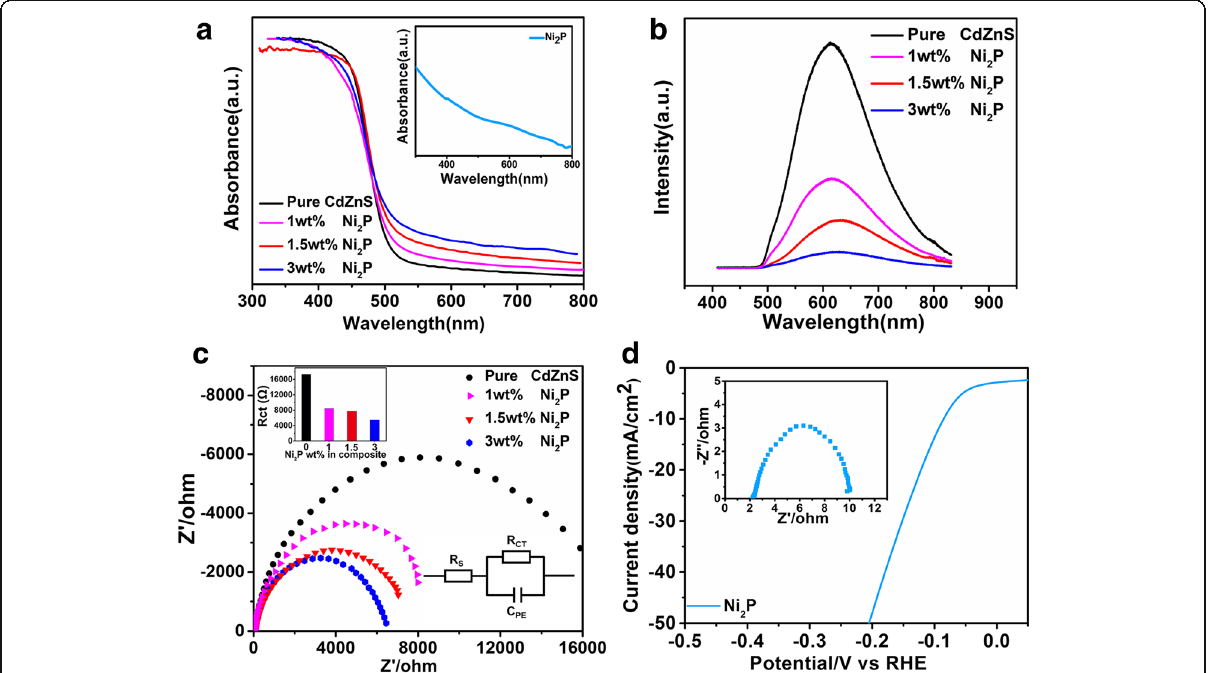
Fig. 4 The effect of Ni 2 P content on the optical and electrochemical properties of Ni 2 P-Cd 0.5 Zn 0.5 S composite. a UV-Vis absorption spectra (inset pure Ni 2 P), b photoluminescence spectra, and c EIS spectra. d LSV curve and EIS (inset) spectrum of pure Ni 2